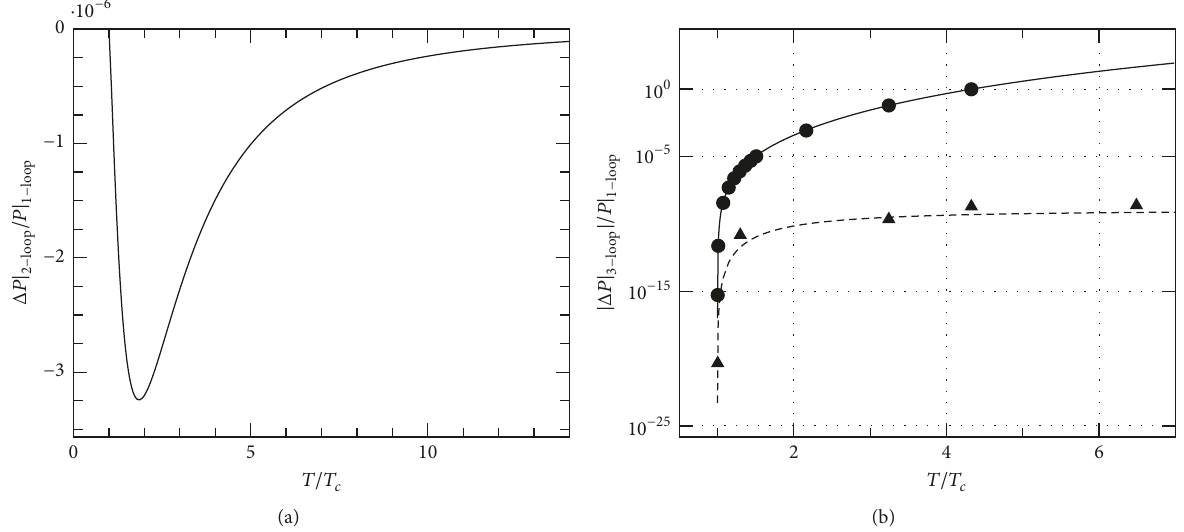
(solid) and loop ,𝑠𝑠 𝑇